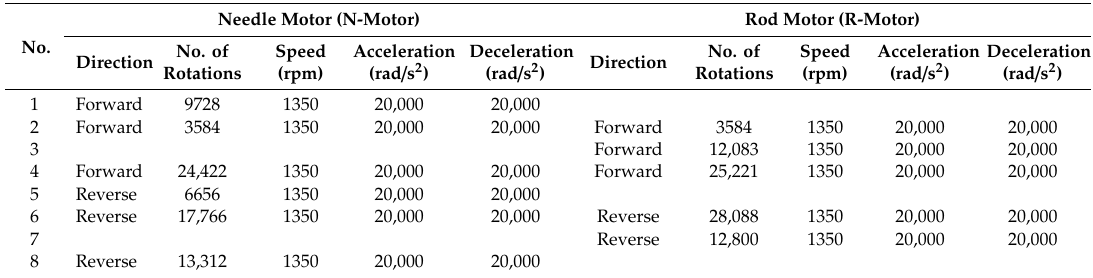
Table 1. Setting value of each motor per transplant